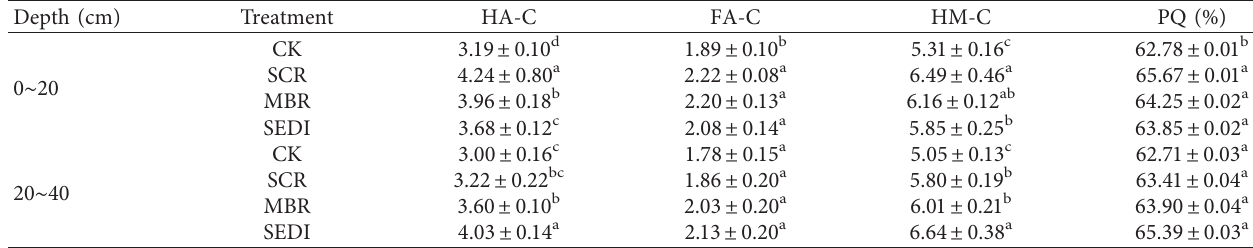
Table 2: Effect of different treatments of corn straw on humic substances in black soil. Depth (cm)